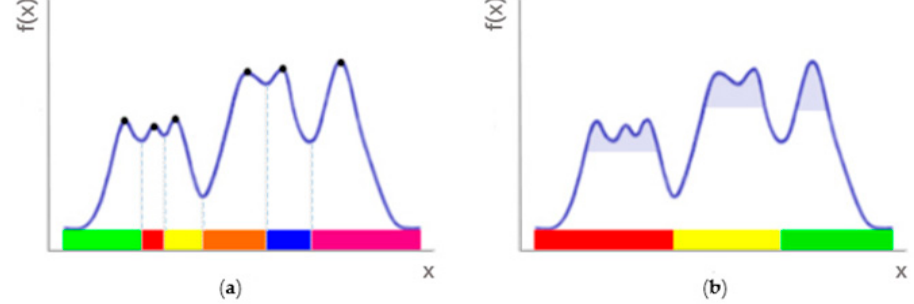
Figure 12. ( a ) High-density regions may have variations and too many apparent modes appear, leading to over-segmentation; ( b ) using modal-sets (shaded) not only allows disturbances within limits of different shape of regions of high density, but also matches various density levels, regarding them as the same cluster.